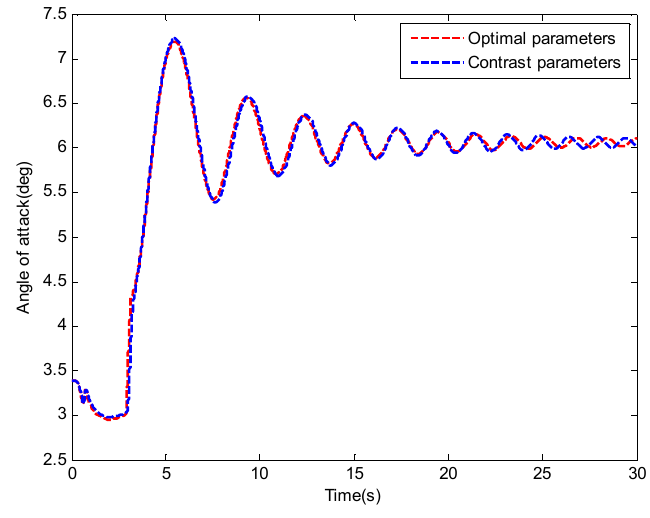
Figure 9. Angle of attack of aircraft.